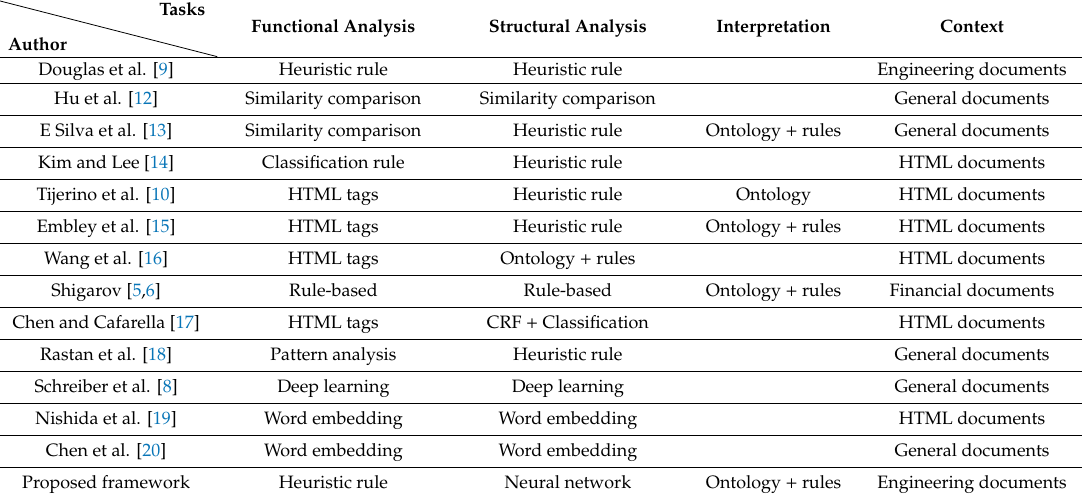
Table 1. Table understanding